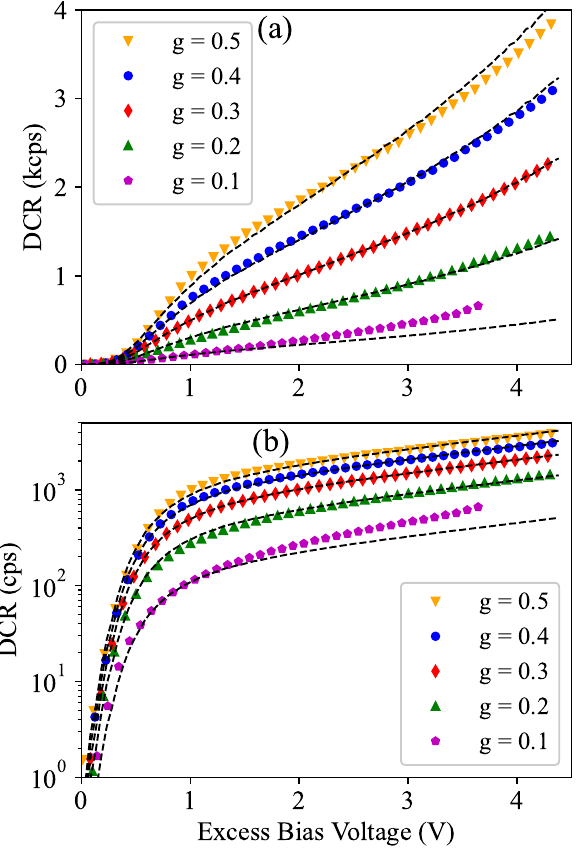
Figure 7. Dark-count rate as a function of the excess bias voltage at different duty cycle ( g ) values plotted in linear ( a ) and logarithmic ( b ) scale. The dashed lines show the model fit using Equation